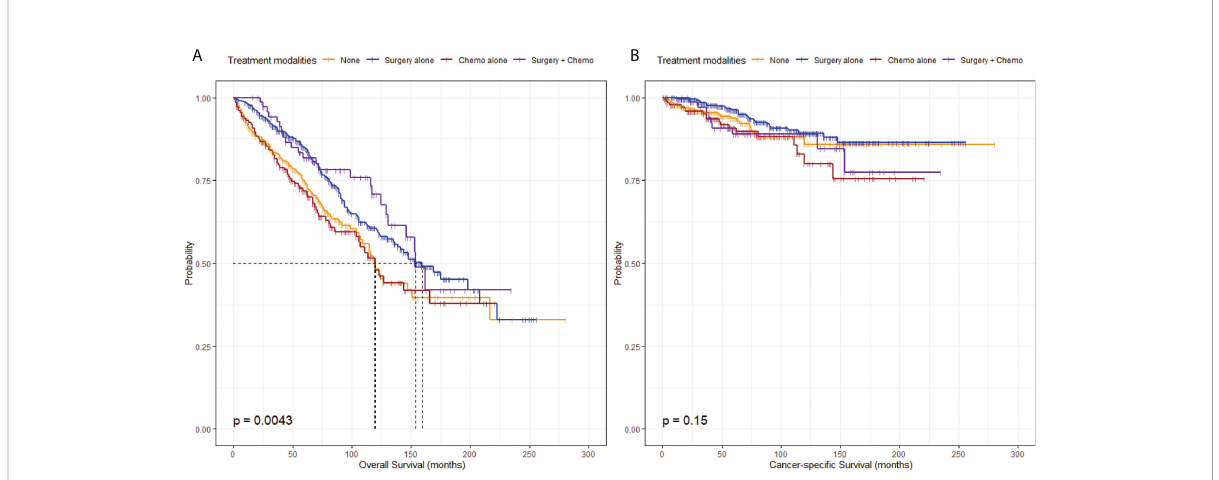
FIGURE 2 Kaplan-Meier survival curves strati fi ed by treatment modalities before propensity score-matching. (A) Kaplan-Meier survival curve of overall survival strati fi ed by treatment modalities. (B) Kaplan-Meier survival curve of cancer-speci fi c survival strati fi ed by treatment